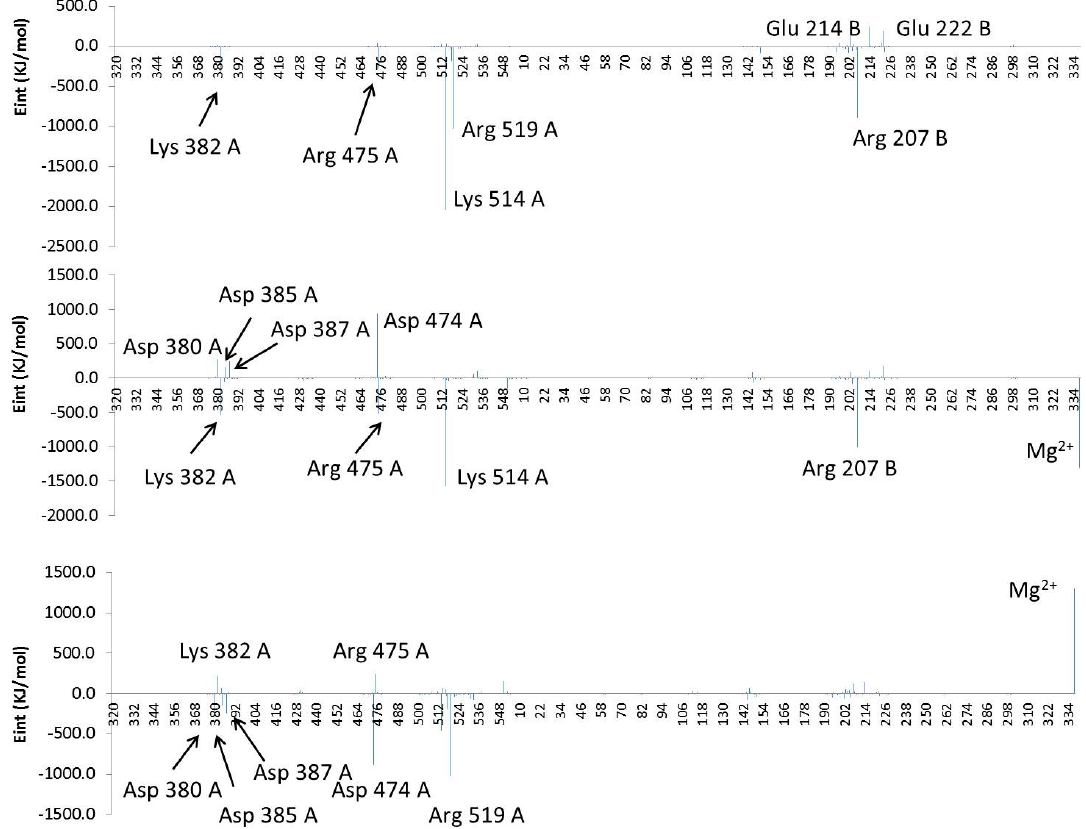
Figure 8. Contribution of individual amino acids to (poly-P)-protein interaction energy (Eint, in kJ·mol − 1 ) for the wild type ( top panel ), 1H2 mutant ( middle panel ) and differences between both systems ( bottom panel ). Residues are ordered according to the sequence, and the Mg 2+ ions are added at the end . Results derived from the QM–MM interaction term of the QM/MM optimizations.